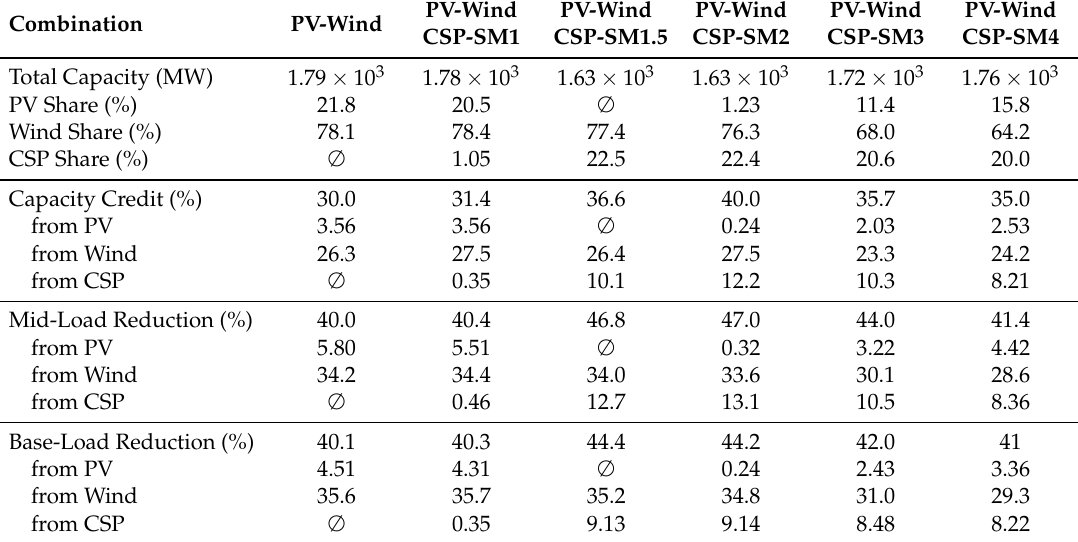
Table 8. Properties of the optimal mix at 16% penetration for the global strategy with the maximum-cost constraint and for different combinations.